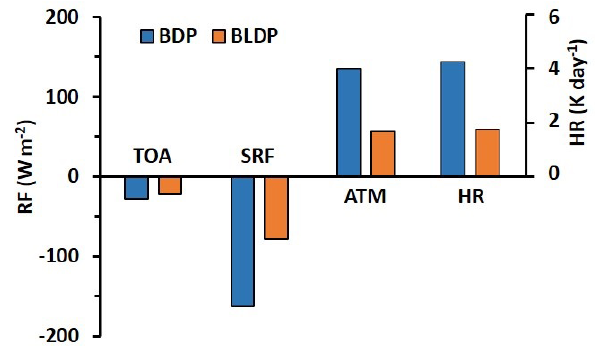
Figure 10. Episode-specific aerosol shortwave radiative forcing and atmospheric